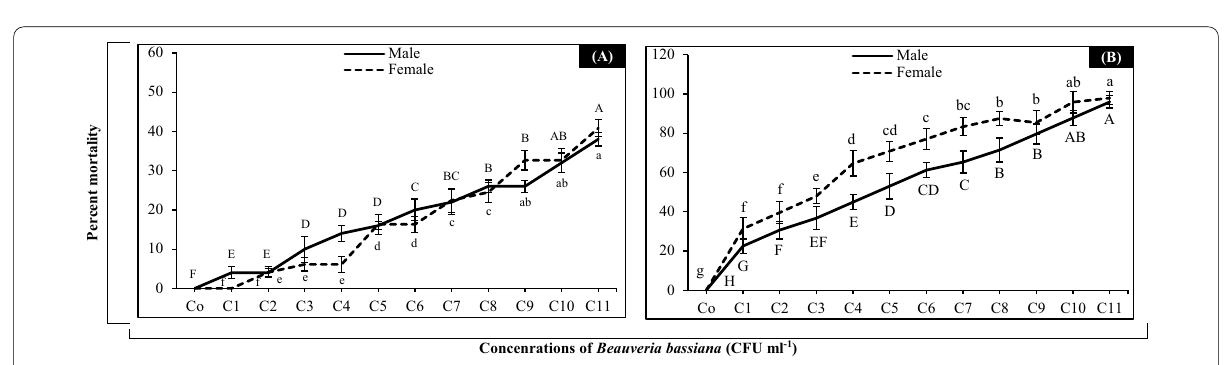
Fig. 2 Percent mortality of both sexes of Bactrocera zonata for different concentrations of Beauveria bassiana (solid and square-dotted lines represent mortality of male and female Bactrocera zonata , respectively; Capital and small letters represent mortality of male and female Bactrocera zonata , respectively) at 5 days post-exposure intervals (a) and 7 days post-exposure intervals (b) . Concentrations on x-axis represents C0 C1 1 10 3 CFU ml − 1 , C2 = × C7 1 10 6 CFU ml − 1 , C8 = × the standard error; means sharing similar style letters do not significantly differ at probability level of 5%. The mean values of lines (solid and ± square-dotted) bearing similar letters do not differ